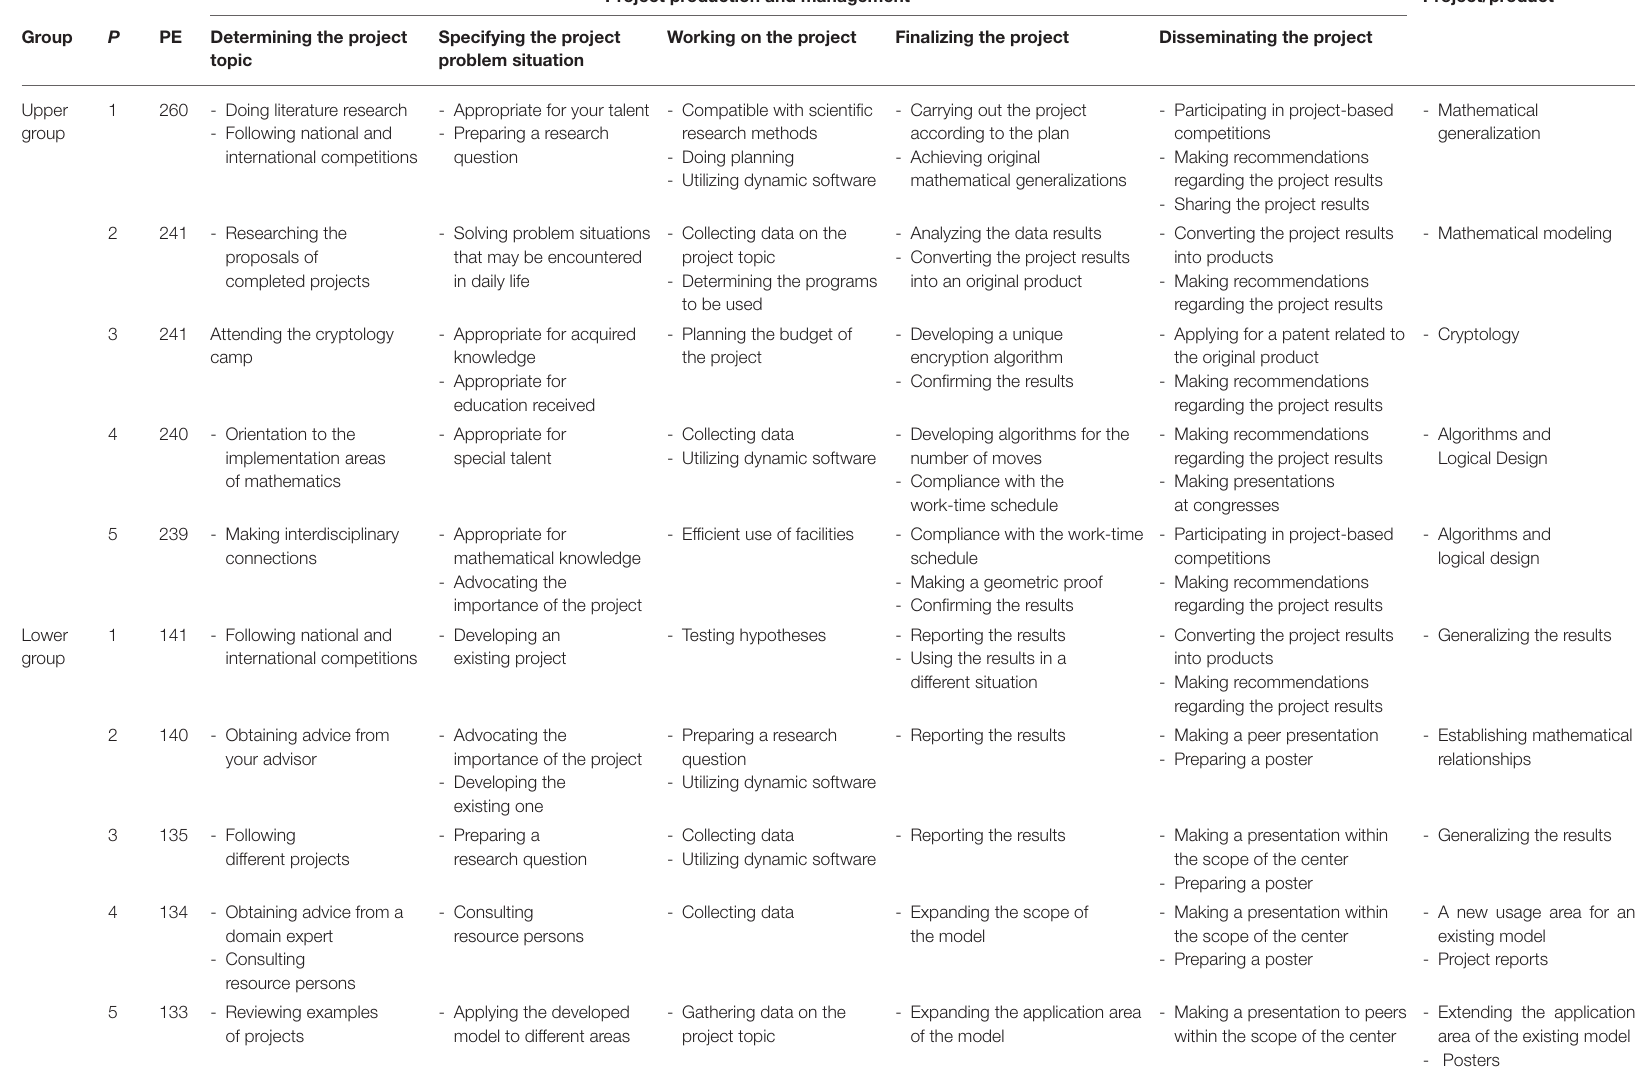
TABLE 5 | Project production and management findings of upper and lower group